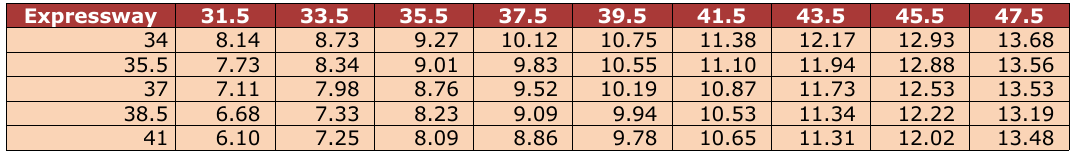
Table 6. Operating earnings of Nanchang-Jiujiang Expressway